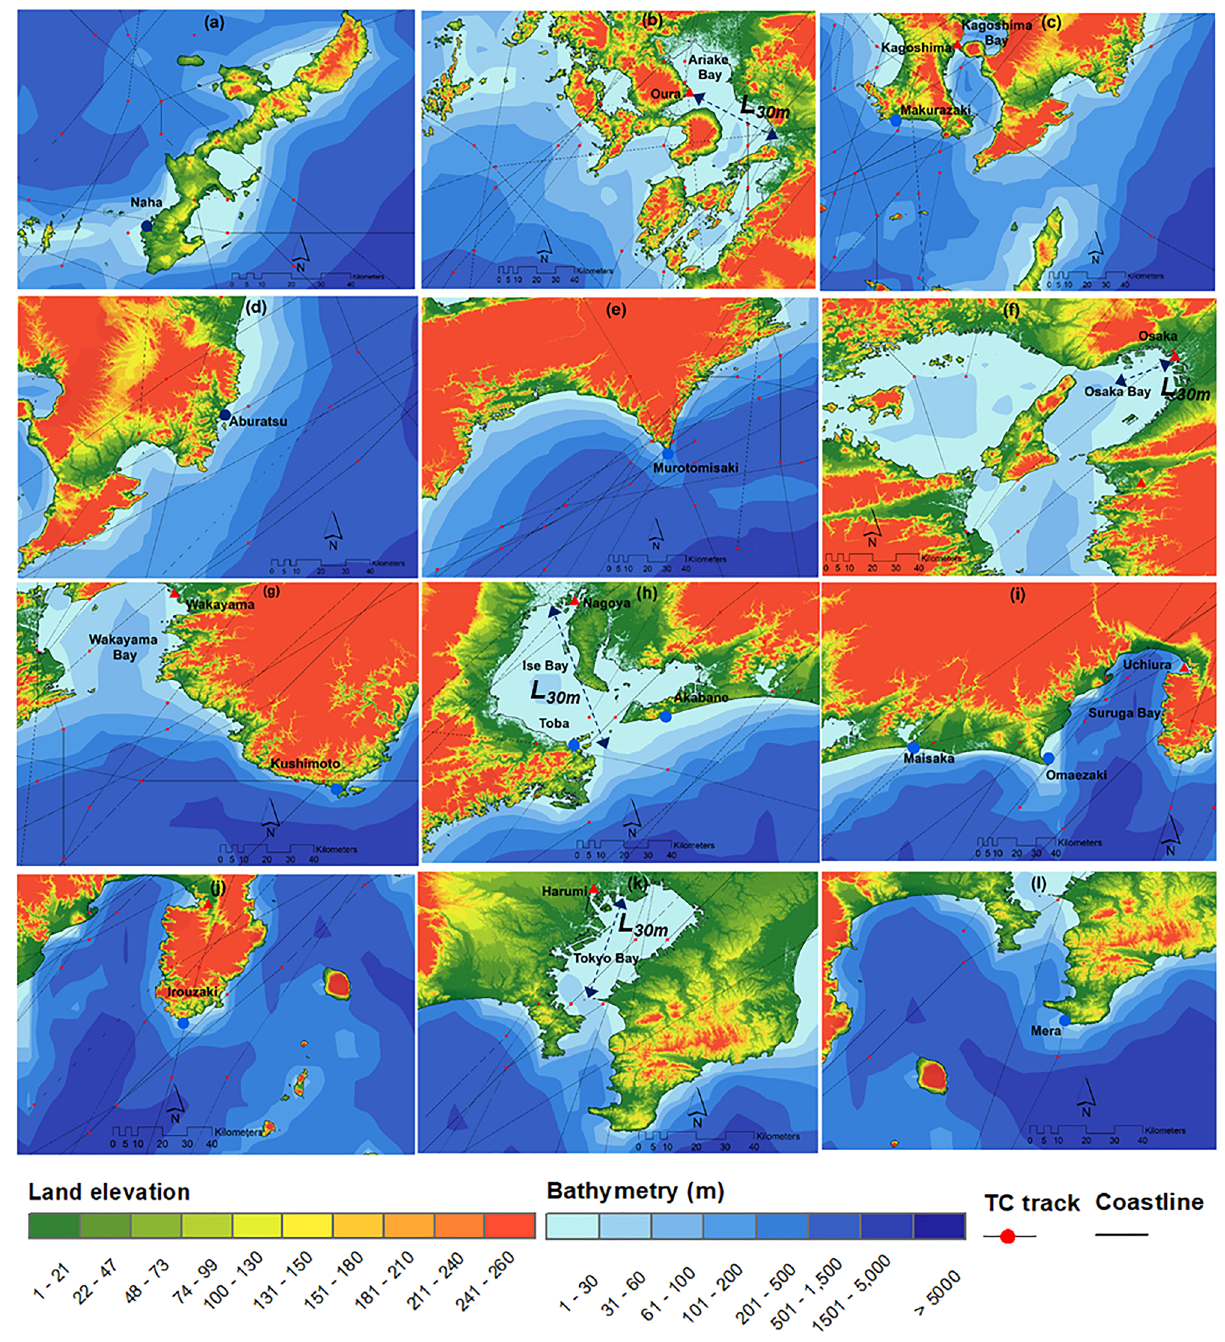
Figure 2. Location map of observed tide stations (a) Naha, Okinawa island; (b) Oura, Kyushu island; (c) Makurazaki and Kagoshima, Kyushu island; (d) Aburatsu, Kyushu island; (e) Murotomisaki, Shikoku island; (f) Osaka, Honshu island; (g) Wakayama and Kushimoto, Honshu island; (h) Toba, Nagoya, and Akabane, Honshu island; (i) Maisaka, Omaezaki, and Uchiura, Honshu island; (j) Irouzaki, Honshu island; (k) Harumi, Honshu island; (l) Mera, Honshu island. All maps are created using ArcMap (v.